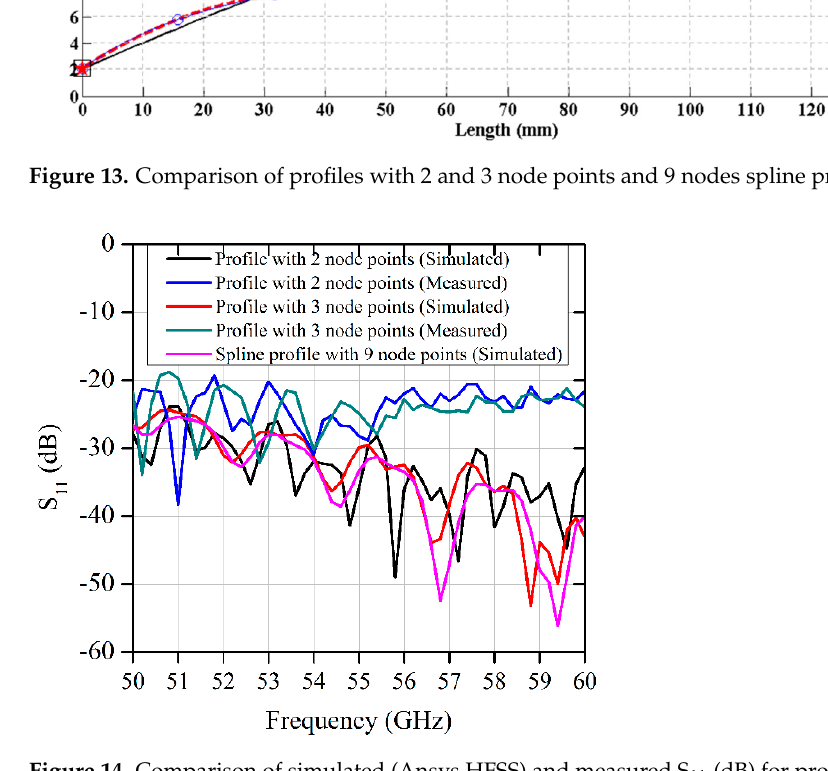
Figure 14. Comparison of simulated (Ansys HFSS) and measured S 11 (dB) for profiled horn antenna with 2 and 3 node points and 9 nodes spline profile horn.